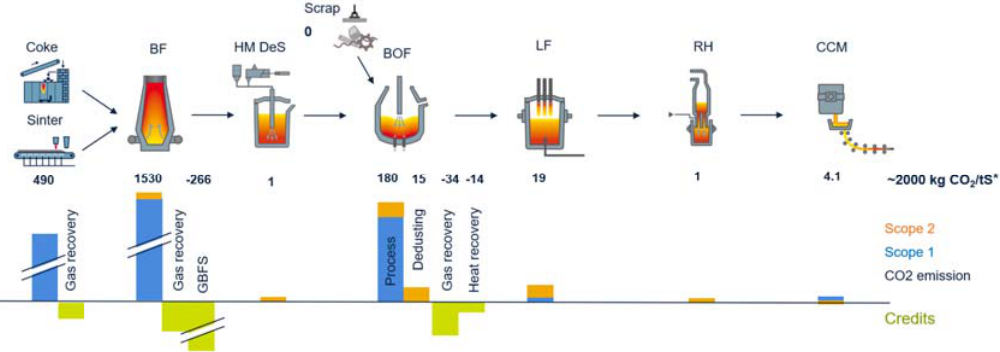
Figure 5. Scope 1 and scope 2 CO 2 emissions for integrated BF-BOF steelmaking including credits per ton of output product. * Specific values based on an electricity grid factor of 450 gCO 2 /kWh.